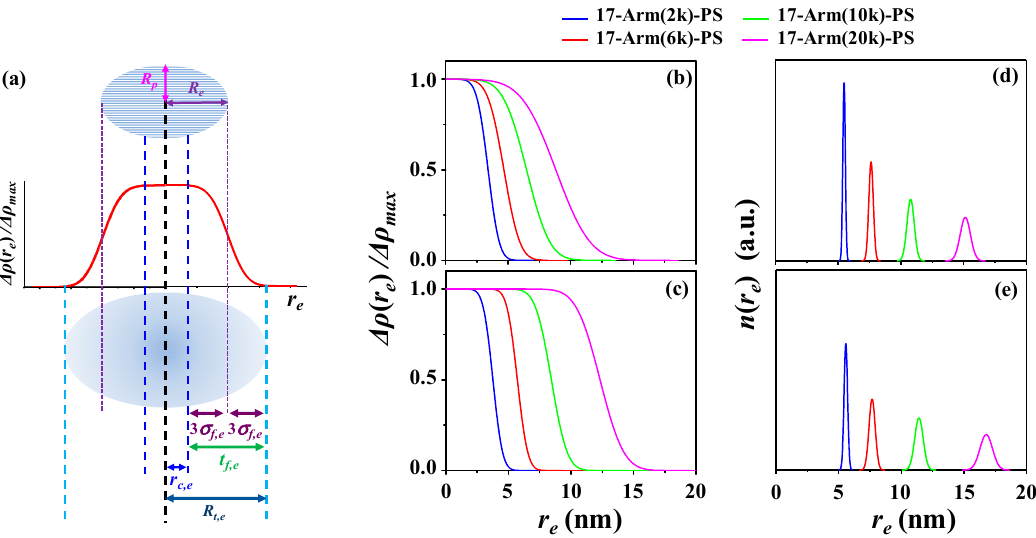
Figure 8. Fuzzy ellipsoidal structure, radial density profiles, and radial distributions determined by the quantitative analysis results of X-ray scattering data in Figure 7. ( a ) Oblate fuzzy ellipsoid in the front view of cross section and its structural parameters and radial density profile along the equatorial direction. Radial density profiles: ( b ) CHX at 35.0 ° C ( Θ condition); ( c ) THF at 25.0 ° C (good solvent); radial distributions: ( d ) CHX at 35.0 ° C ( Θ condition); ( e ) THF at 25.0 ° C (good solvent).